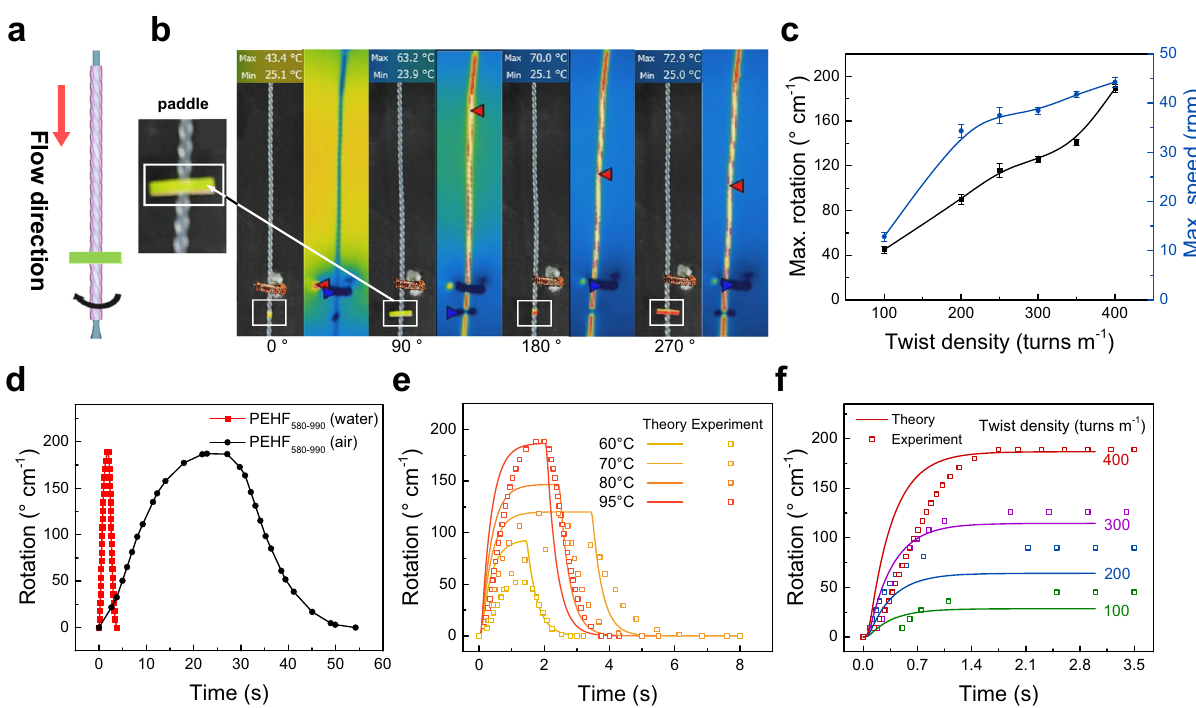
Fig. 2 Actuation performance of torsional PEHF 580-990 actuators. a Schematic and b serial images of a twisted PEHF 580-990 actuator during water fl ow. c Maximum rotation angle and maximum rotation speed as a function of inserted twist density. d Comparison of the torsional PEHF 580-990 actuator driven by 95 °C water and air. e , f Experimental and theoretical results of the rotation angle as a function of time for the twisted PEHF 580-990 actuator at different temperatures ( e ) and inserted twist densities ( f ). If not speci fi ed, in the following fi gure captions, the actuation was driven by 95 °C water, and the water fl ow rate was 0.5 g s − 1 . If not speci fi ed, the error bars in c and in the following fi gures indicate standard